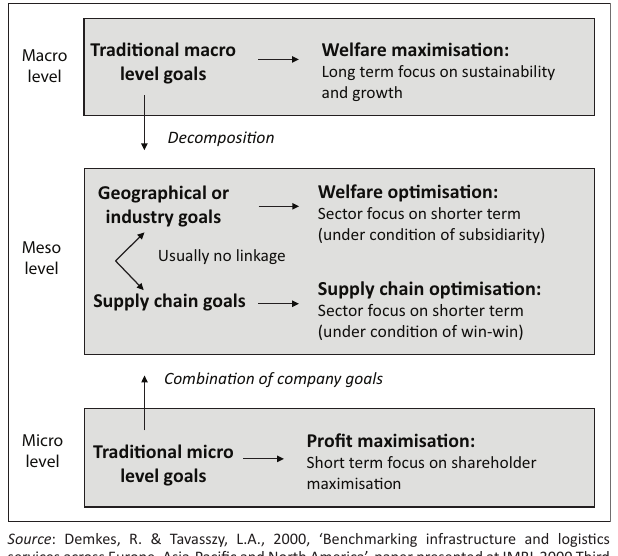
FIGURE 1: Micro-, meso- and macro-level